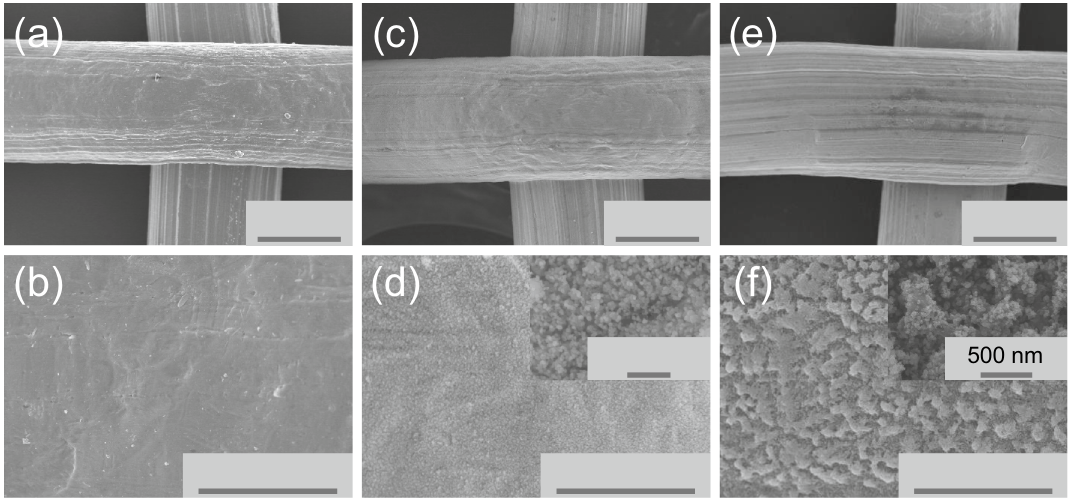
Figure 2. SEM images of an untreated stainless steel mesh ( a , b ), plasma treated mesh with case 1 ( c , d ) and case 2 ( e , f